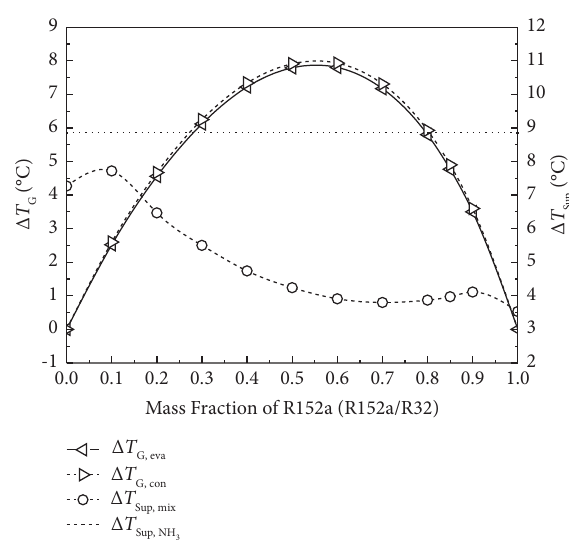
Figure 4: T-S diagram of three working fuids.